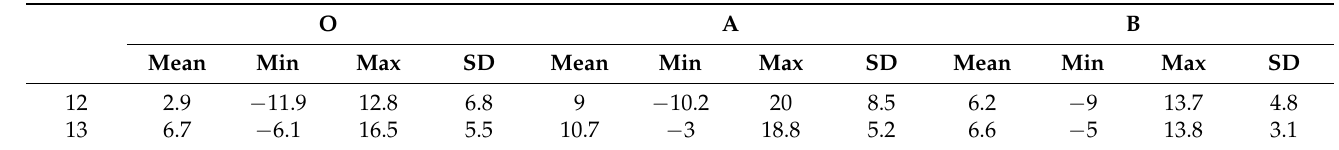
Table 4. Descriptive statistics of temperature at each test point on the 12th and 13th ( ◦ C).